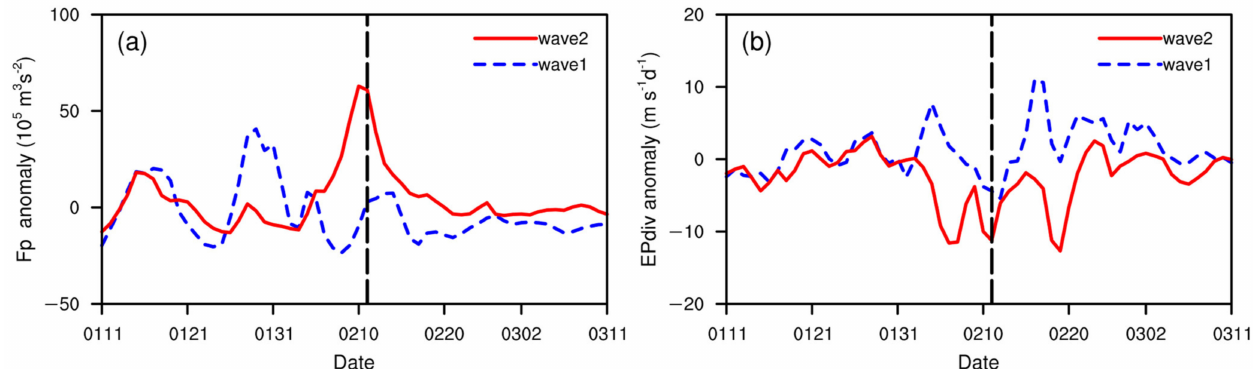
Figure 3. The temporal evolution of ( a ) the vertical component of EP flux anomaly (i.e., Fp anomaly) of wave 1 (dashed line) and wave 2 (solid line) averaged from 55 ◦ N to 75 ◦ N at 10 hPa; ( b ) EP flux divergence anomaly (i.e., EPdiv anomaly) of wave 1 (dashed line) and wave 2 (solid line) averaged from 55 ◦ N to 75 ◦ N, from 100 hPa to 10 hPa. The vertical dashed line represents the onset day of the 2018 SSW event. Note that the anomalies just remove the annual